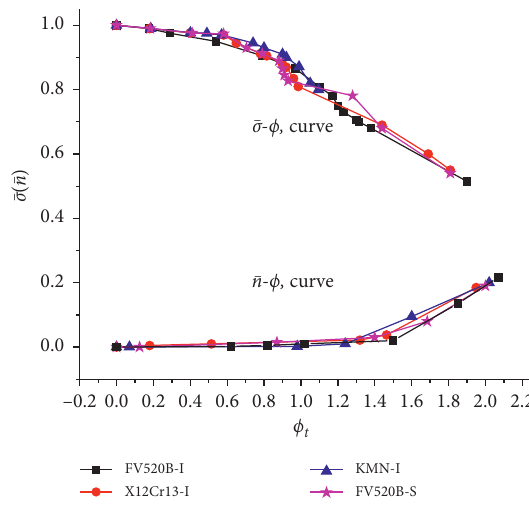
Figure 1: σ − n − Φ t curve of these four